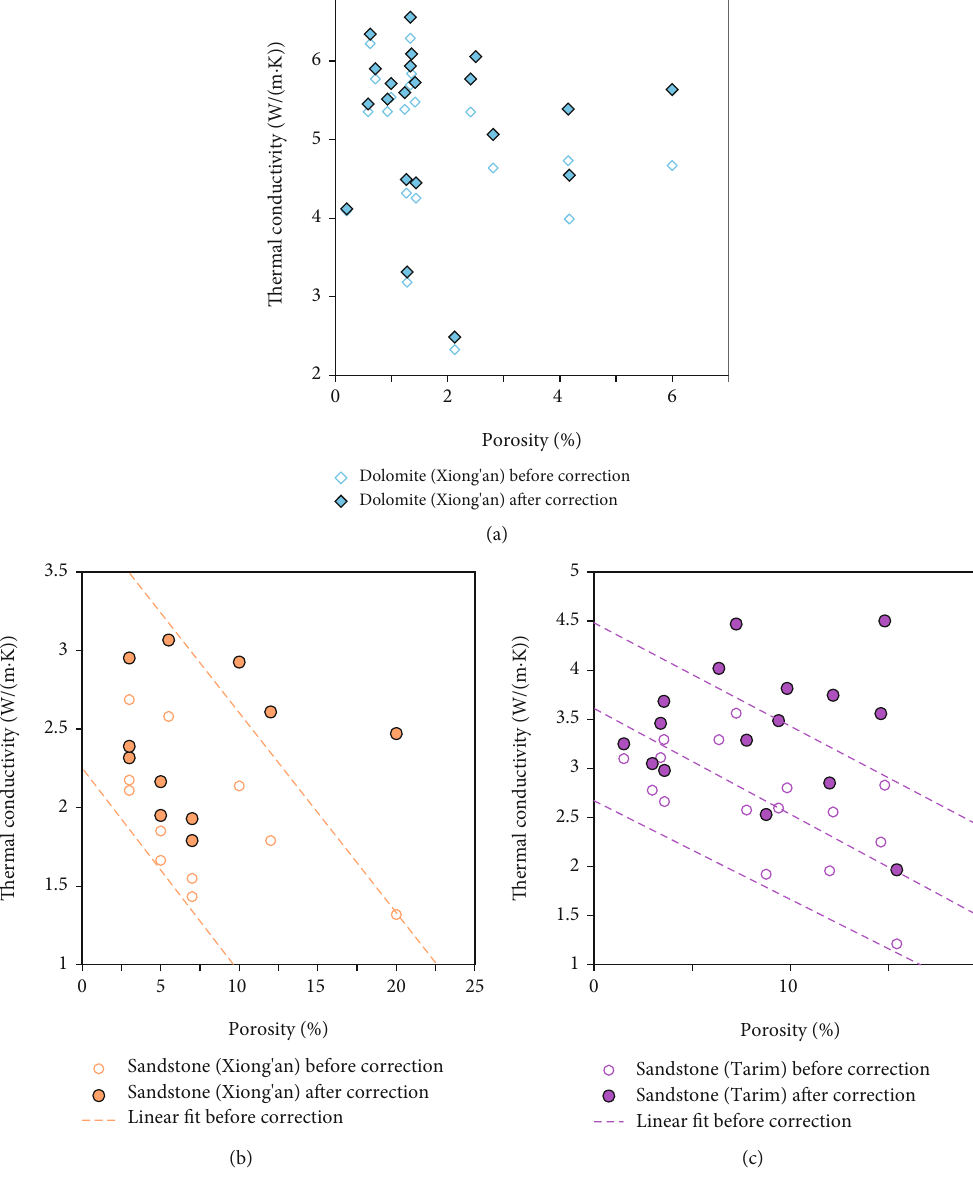
Figure 13: Thermal conductivities before and after correction varied with porosity. (a) Dolomite in Xiong ’ an New Area. (b) Sandstone in Xiong ’ an New Area. (c) Sandstone in Tarim